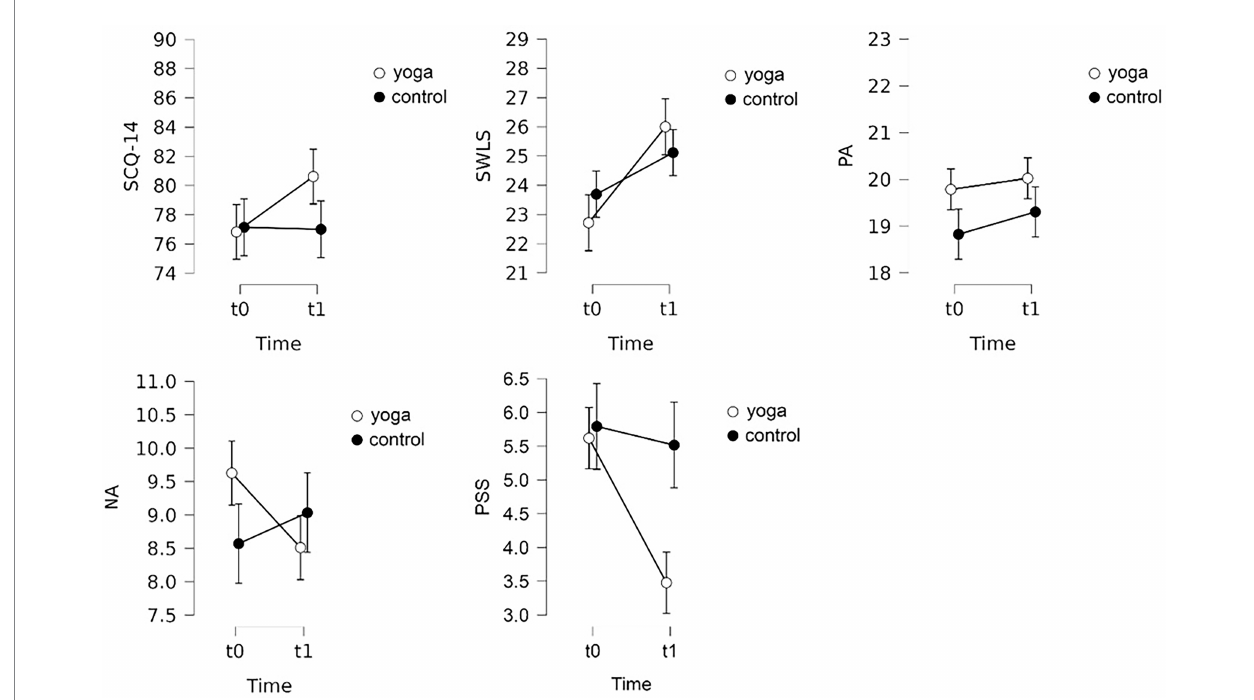
FIGURE 2 Descriptive plots of the Spiritual Connection Questionnaire (SCQ-14), Satisfaction with Life Scale (SWLS,) Positive and Negative Affect Schedule’s Positive Affect (PA) and Negative Affect (NA) scales, and the Perceived Stress Scale (PSS). Error bars indicate 95% confidence